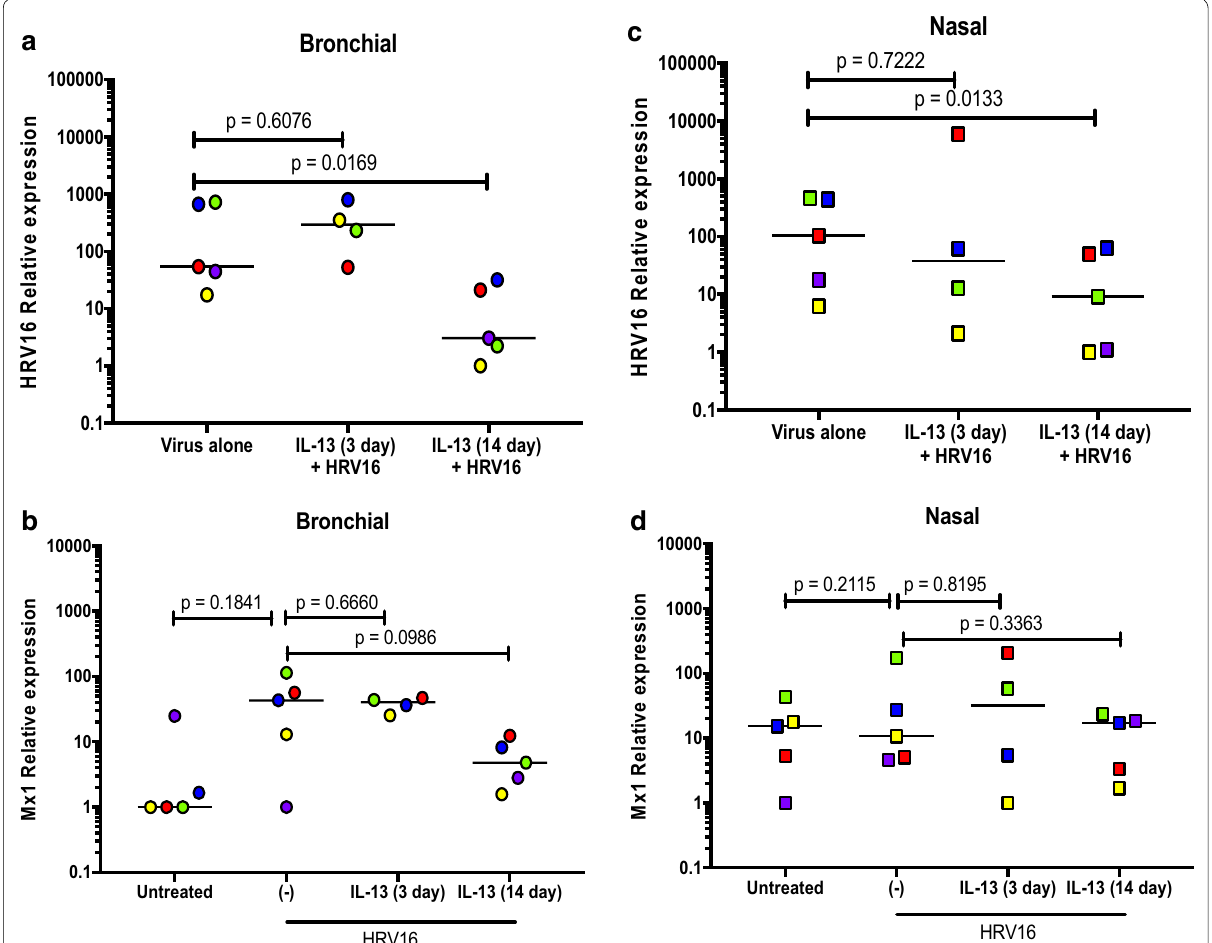
Fig. 4 Effects of IL-13 treatment on human rhinovirus 16 (HRV16) infection in air–liquid interface (ALI) cultures of paired human primary bronchial and nasal epithelial cells. Viral load and Mx1 mRNA expression were measured in bronchial ( a , b ) and nasal ( c , d ) epithelial cells exposed to acute and chronic IL-13 treatments and/or HRV16. Each of the colored solid circles (n horizontal lines indicate